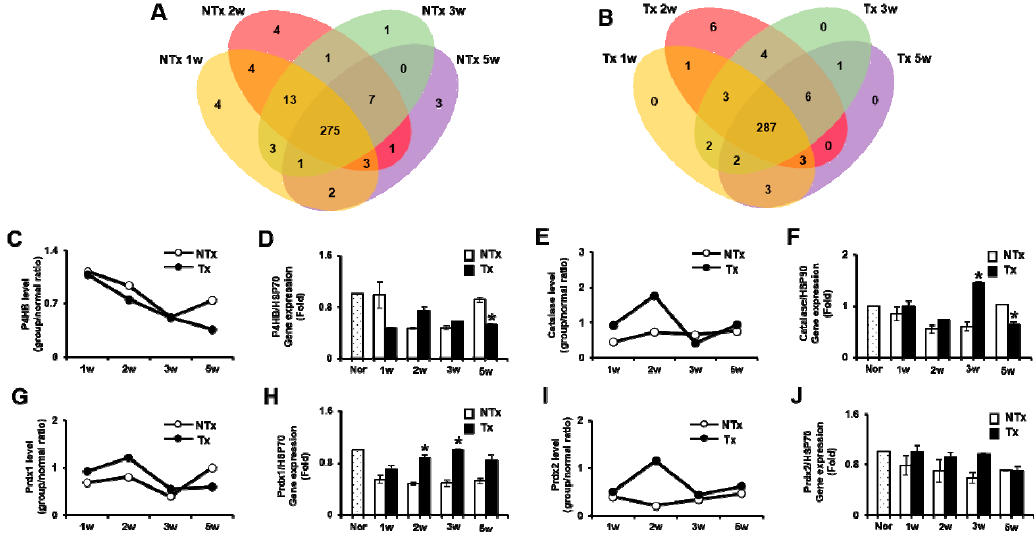
Figure 2. PD-MSCs trigger the upregulated expression of antioxidant enzymes in the exosome of the OVX rat model. The differences of factors in exosomes as a Venn diagram ( A and B ). The P4HB expression related to the reactive oxygen species (ROS) level was analyzed in the exosome of serum ( C and D ). The catalase ( E and F ), Prdx1 ( G and H ), and Prdx2 ( I and J ) expressions related to antioxidants were analyzed in the exosome of serum. The data are representative of three independent experiments and expressed as means ± SD. * p < 0.05 : NTx vs. Tx